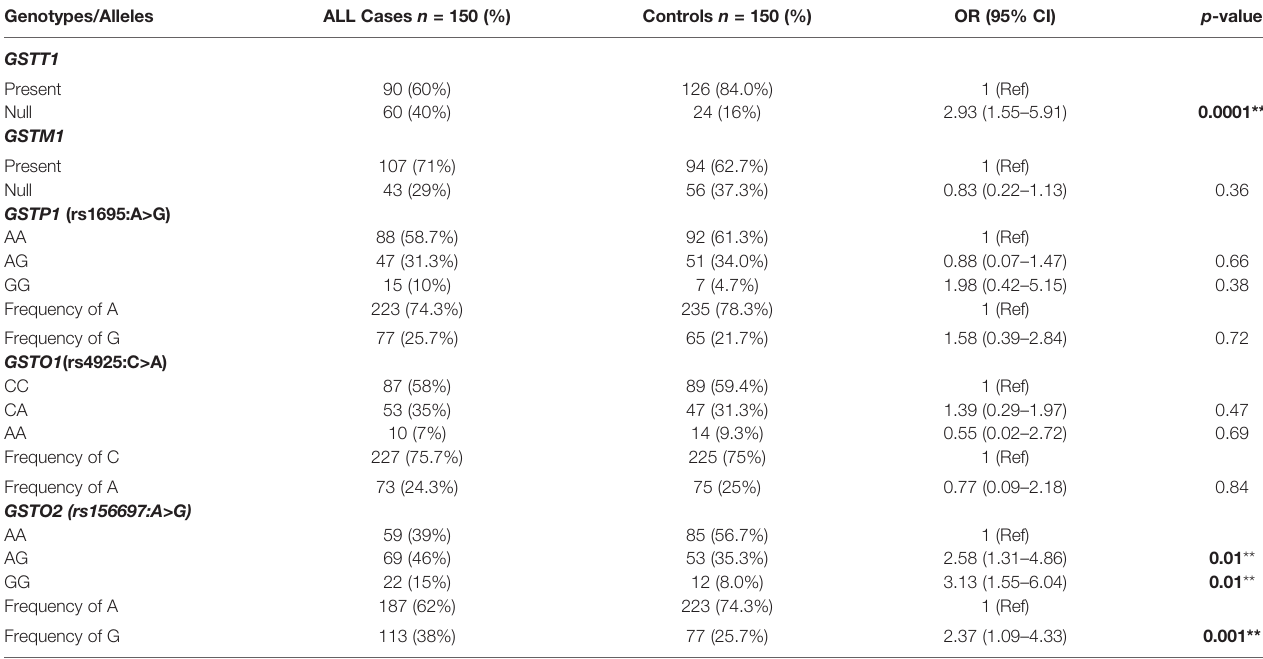
TABLE 2 | Genotypic and allelic distribution of different GST polymorphisms in ALL patients and controls and their association with B-ALL risk.